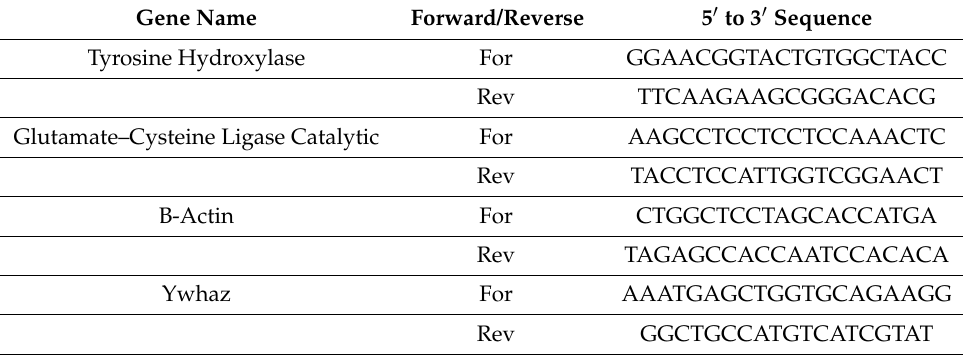
Table 1. Primer sequences for quantitative